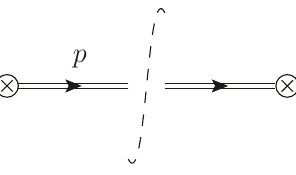
Figure 2 . Lowest order diagram for the jet